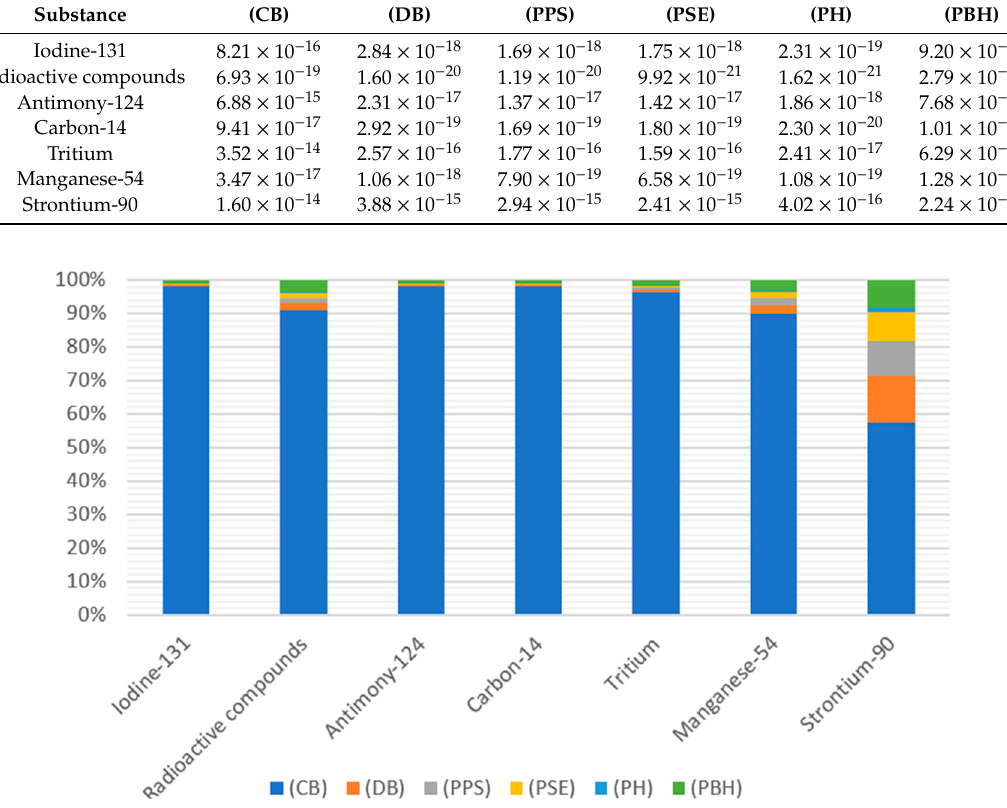
Table 4. Emission of ionizing radiation compounds to water throughout the entire shaping cycle of PLA beverage bottles is biodegradable in an industrial composting facility.